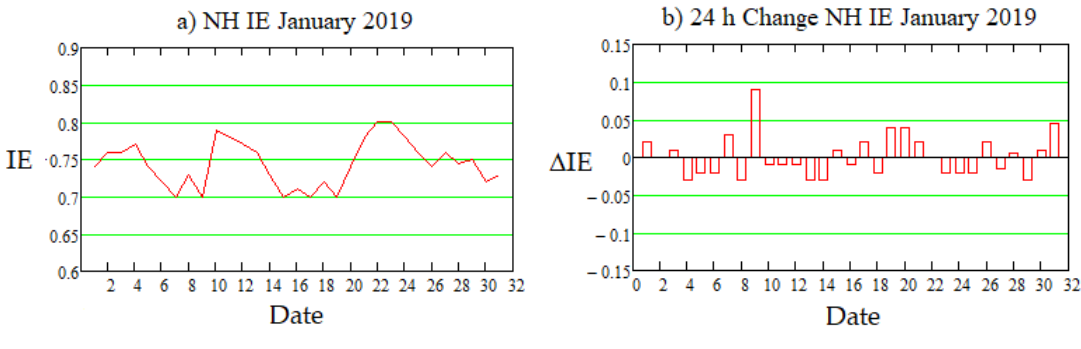
Figure 1. The ( a ) observed Northern Hemisphere (NH) Integrated enstrophy (IE) time series (km 2 s − 2 — solid red line) and ( b ) 24 h change in NH IE (km 2 s − 2 )—red bars) for January 2019. The ordinate is ( a ) IE or ( b ) the change in IE. The abscissa is day of the month.